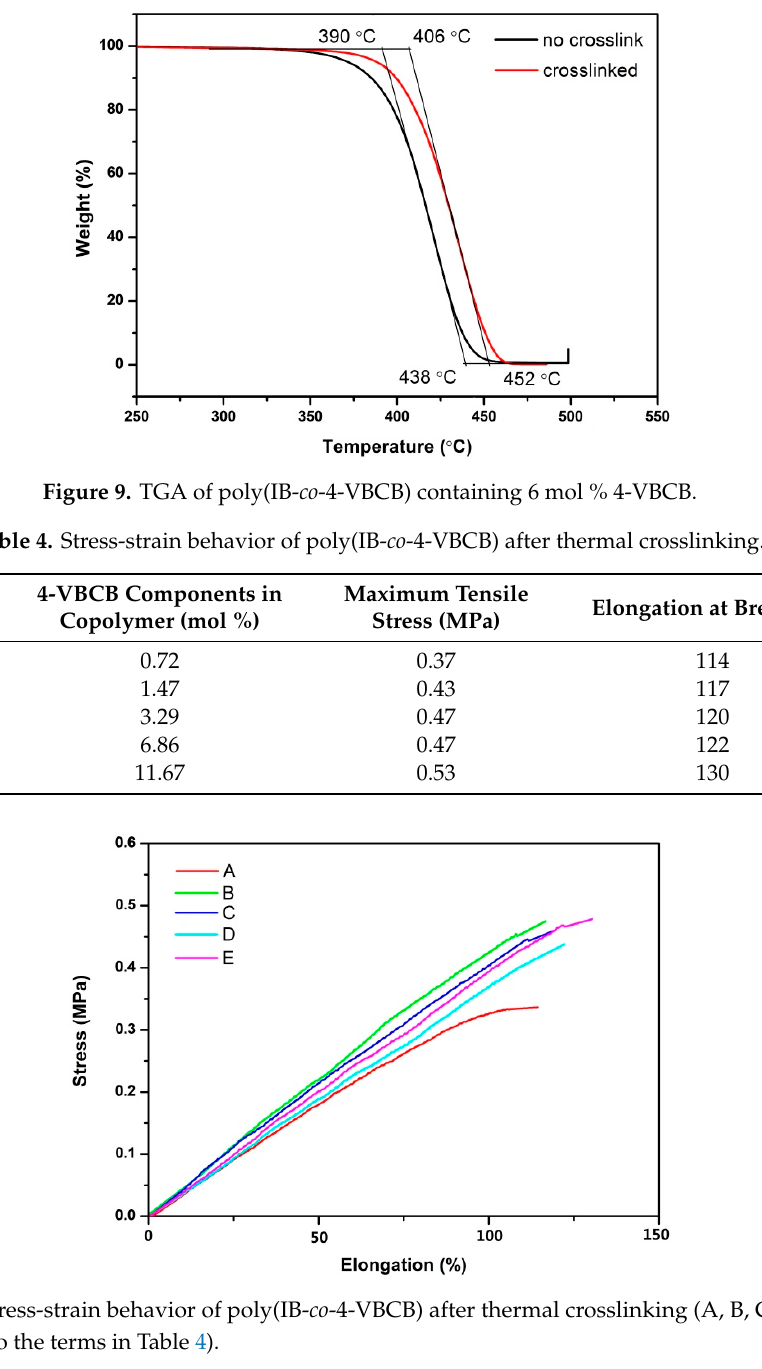
Figure 8. FTIR spectra of the uncrosslinked copolymer ( top ) and crosslinked copolymer ( bottom ).